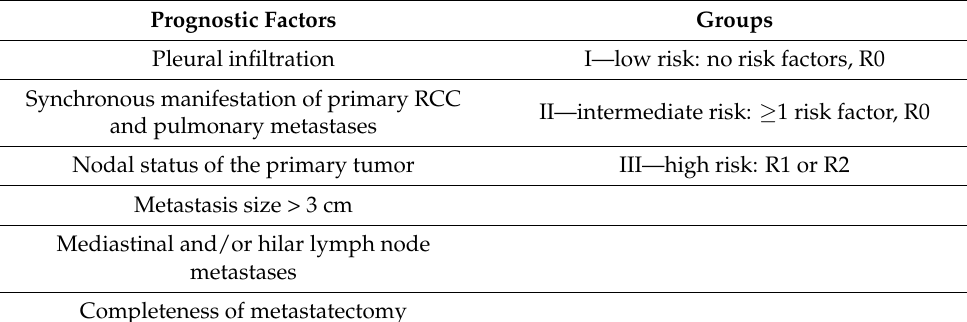
Table 4. Munich score system for lung